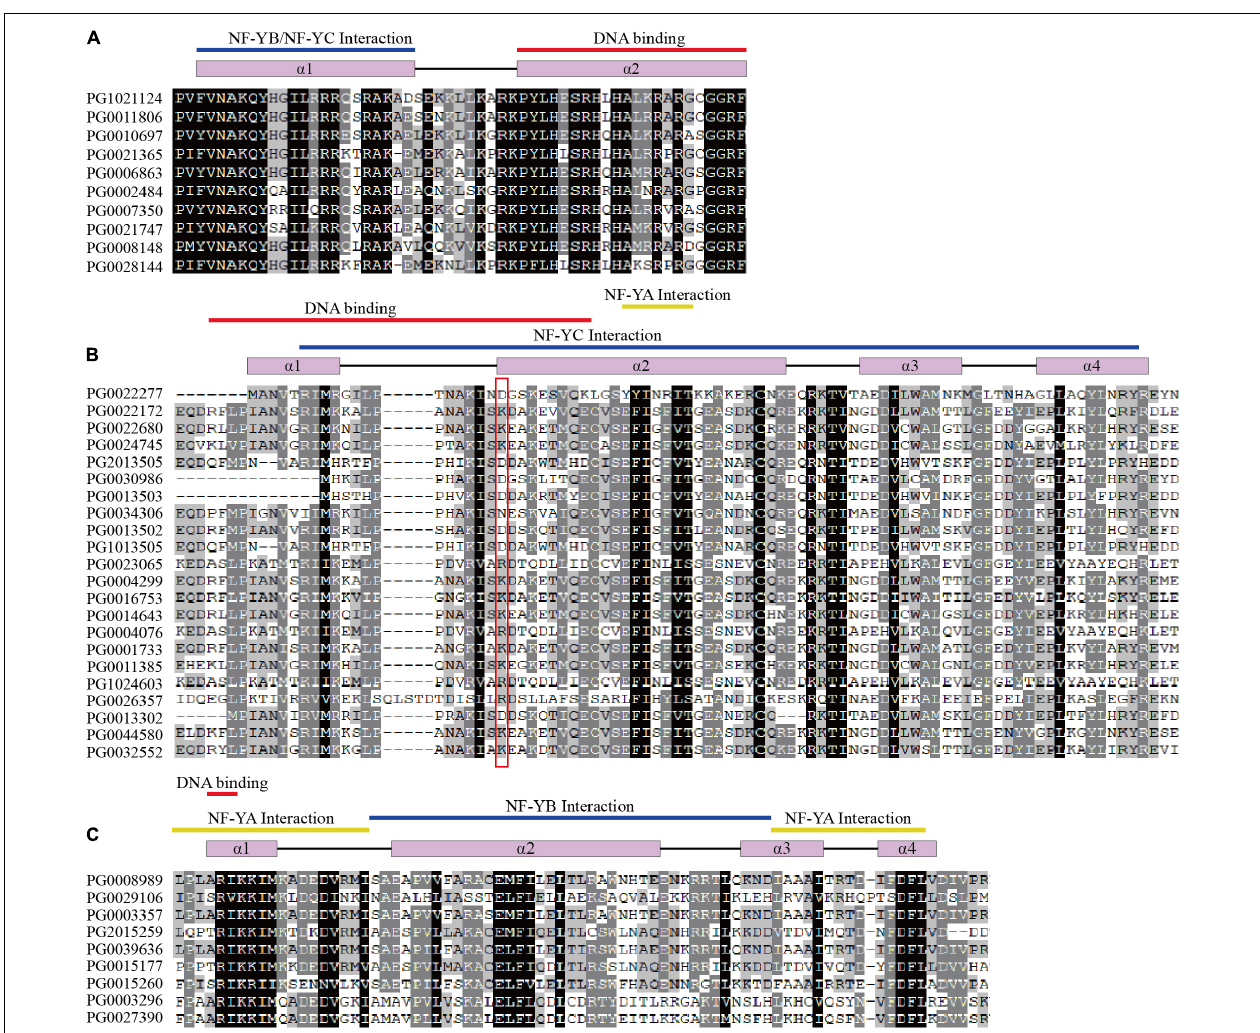
FIGURE 3 | Multiple sequence alignments of StNF-Y family members. (A) Multiple alignments of the StNF-YA conserved domains. (B) Multiple alignments of the StNF-YB conserved domains. (C) Multiple alignments of the StNF-YC conserved domains. The secondary structures of StNF-Ys are indicated at the top of each alignment. The alpha-helices are represented in purple rectangles, and the coils are represented in black lines on the top of the alignment. DNA-binding, yellow lines indicate NF-YA interaction regions, and blue lines indicate NF-YB/YC interaction domains, respectively. The key amino acids that distinguish LEC1 from non-LEC1 are represented in the red